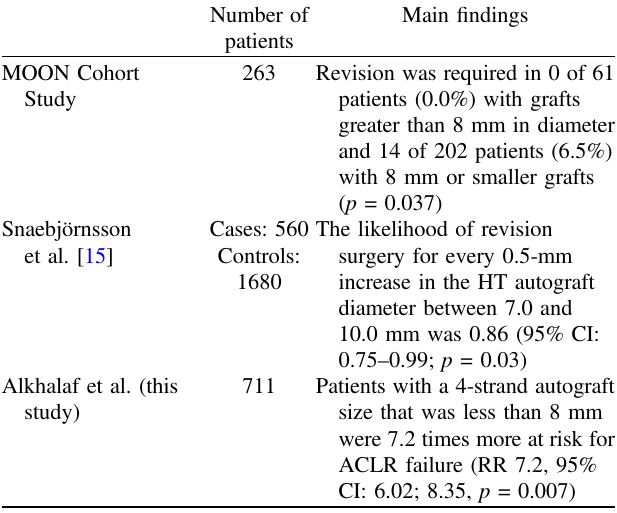
Table 5. Comparison table of results found by large-scale